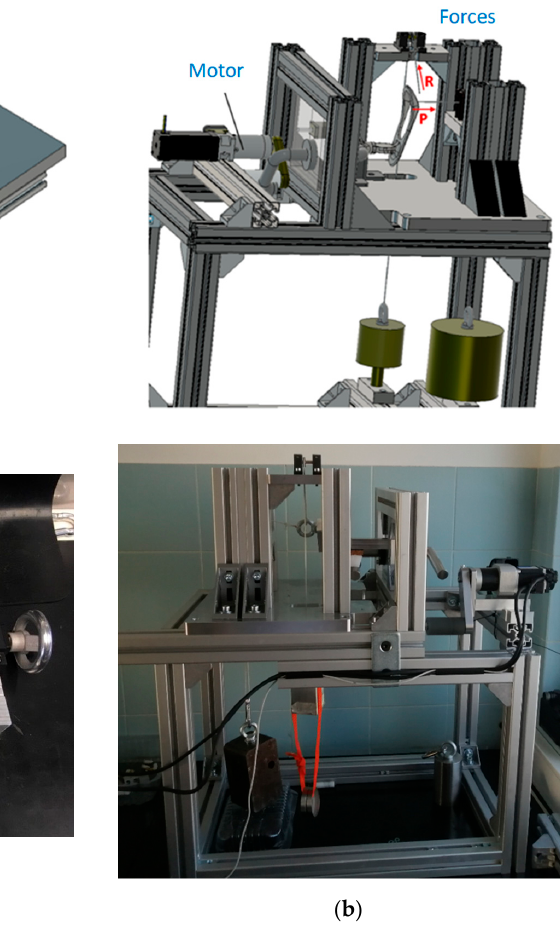
Figure 12. Equipment developed for experimental tests: ( a ) uniaxial traction; ( b ) durability.